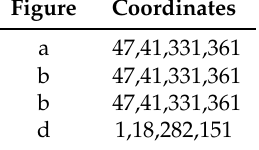
Table 1. Coordinates of the images. Figure